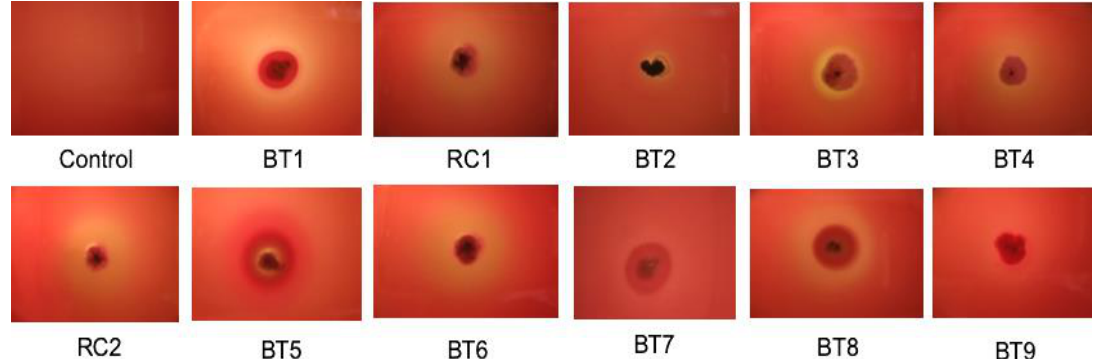
Figure 2. Actinobacterial isolates exhibiting varying degrees of haemolysis on 5% ( v / v ) blood agar plates after 7 days of incubation at 30 °C.